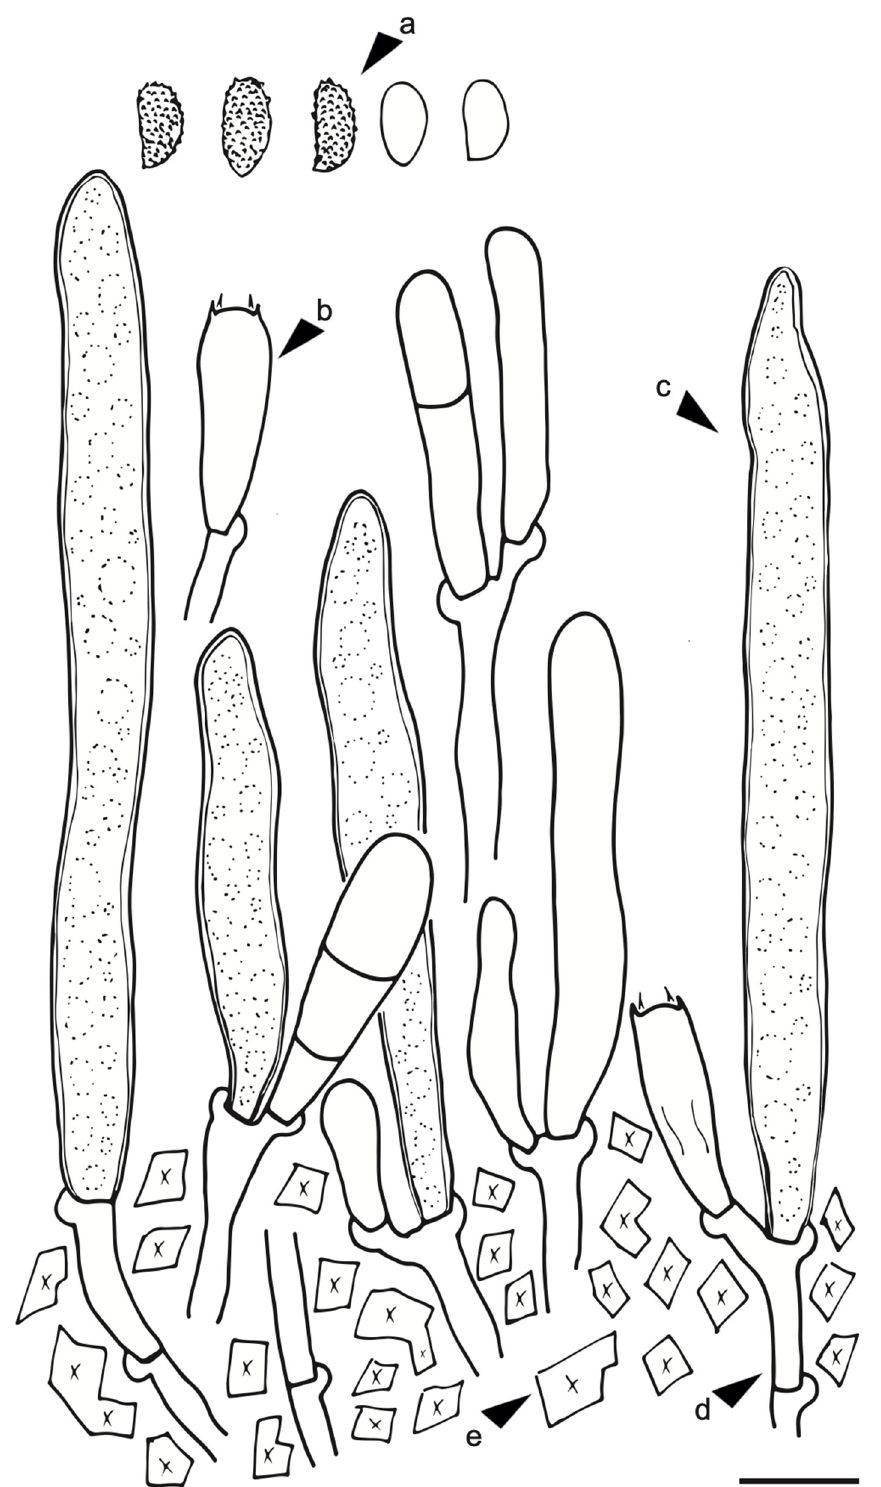
Figure 3. Gloeocystidiellum lojanense sp. nov. coll. [HUTPL(F)2181] (holotype): ( a ). basidiospores verrucose and basidiospores smooth (immature); ( b ). basidia clavate; ( c ). gloecystidia; ( d ). hyphae with clamps; ( e ). calcium oxalate. Scale bars = 10 µm.